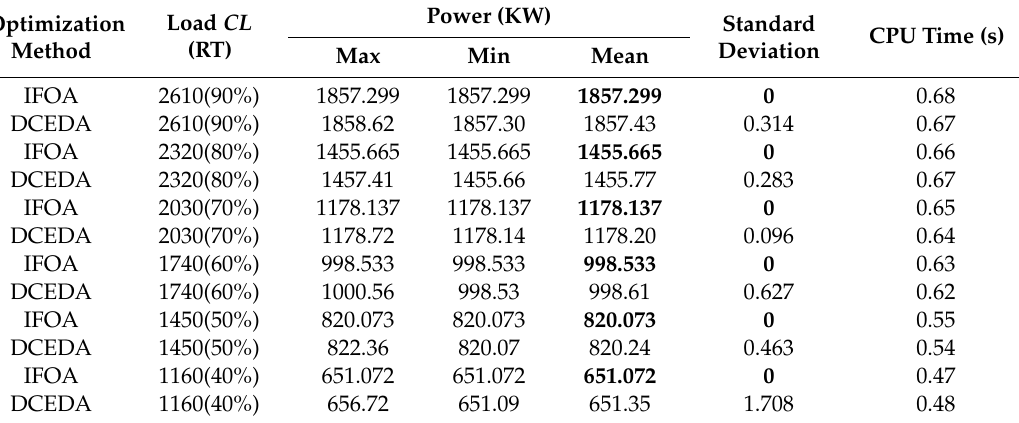
Table 8. Results of objective function in 30 runs in case 2.